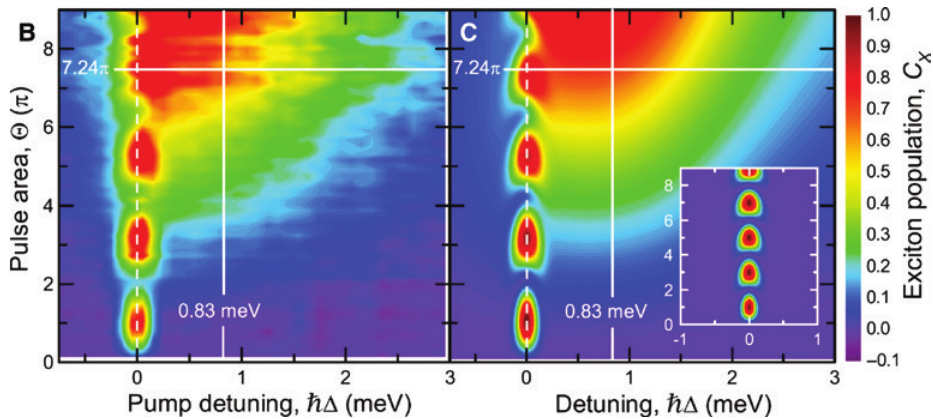
Figure 11: Experimentally obtained (left, B) exciton population versus the pulse area and laser detuning. The path integral solution is given in (C, right) and in very good agreement with the measured signal. The inset (C) shows the calculated values without electron–phonon interaction. Reprinted figure with permission from [25]. © 2015 by the American Physical